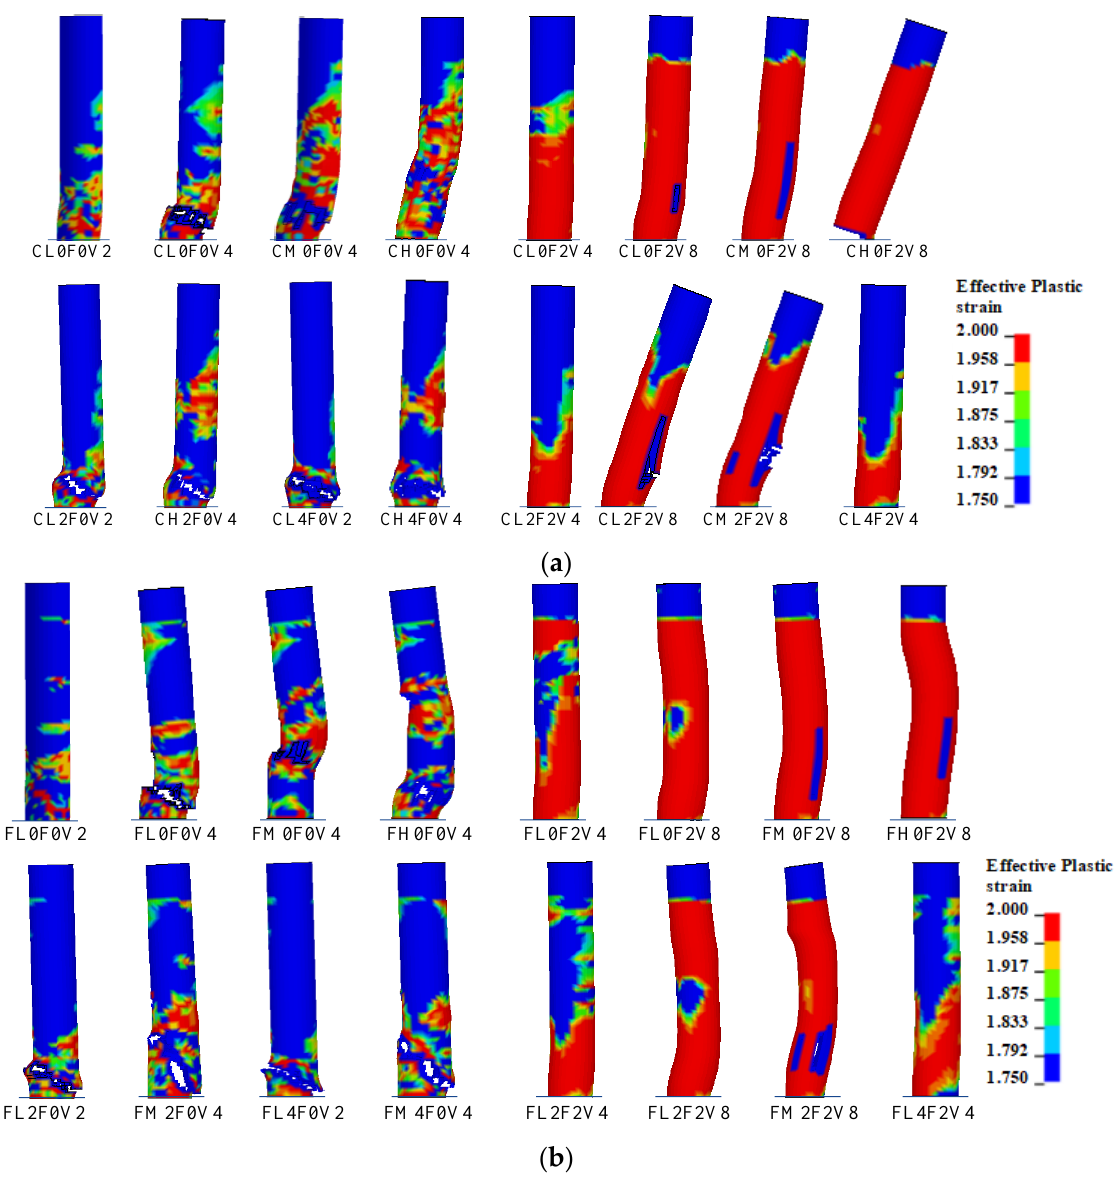
Figure 7. Failure modes: ( a ) C-series columns; ( b ) F-series columns.